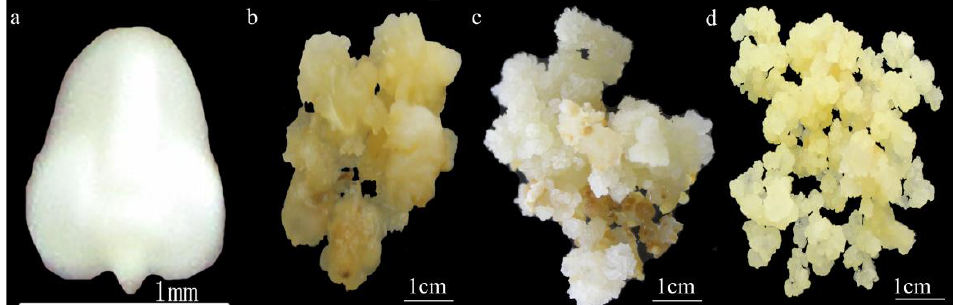
Figure 4. Immature embryos of maize Hi-II hybrid maize (A188*B73 origin) and different states of callus induced from the immature embryos in Induction process. ( a ) Immature embryos were isolated at 1.5–2.5 mm in length; ( b ) Type I callus with clumps of nonpolar cells with a smooth surface and a hard shell, was generated at the edge of the immature shield after 20–40 days on induction medium; ( c ) on induction medium; and, ( d ) Type II callus characterized by bright color, loose structure,